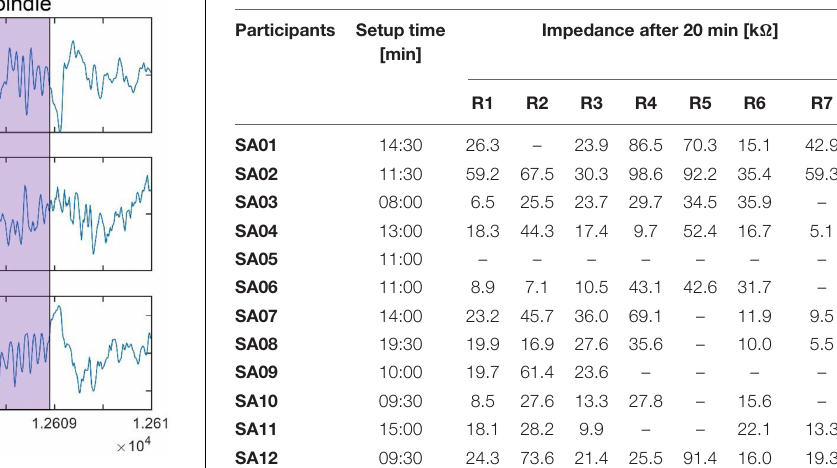
TABLE 5 | Results of self-application study